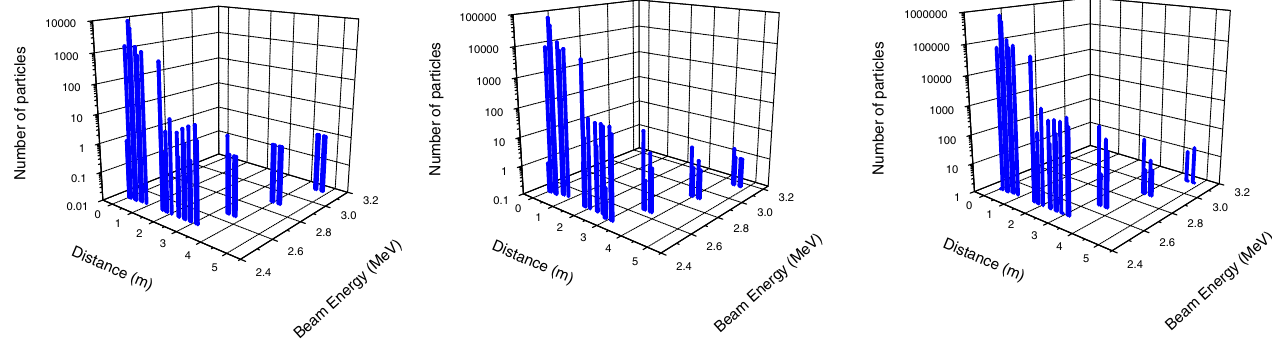
FIG. 15. (Color) Number of lost particles as a function of energy and distance. 10 6 particles (left), 10 7 particles (middle), and 10 8 particles